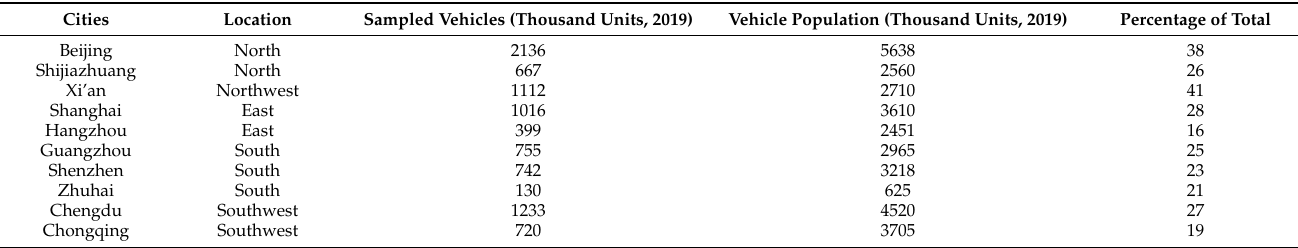
Table 1. Sample size from the I/M